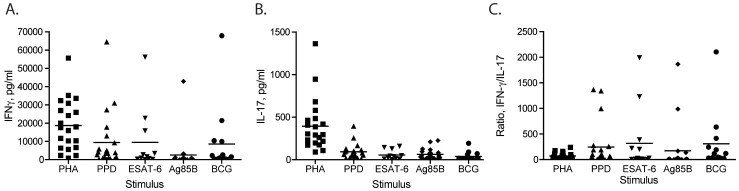
Variation of IFN-γ and IL-17 responses to mycobacterial antigens.PBMC were incubated with the indicated stimuli for 24 h (for IFN-γ responses) or 72 h (for IL-17 responses); cytokine secretion was assayed by ELISA. (A) IFN-γ secretion in response to PHA, PPD, ESAT-6, Ag85B, or live M. bovis BCG. Each symbol reflects responses of a single subject whose responses were assayed in triplicate. The horizontal bar indicates the mean value for the group. (B) IL-17 secretion in response to PHA, PPD, ESAT-6, Ag85B, or live M. bovis BCG. Each symbol reflects responses of a single subject whose responses were assayed in triplicate. The horizontal bar indicates the mean value for the group. (C) Ratio of IFN-γ to IL-17 secretion in response to the stimuli in panels A and B. Ratios were calculated using the mean value for IFN-γ and for IL-17 for each subject; the horizontal bar indicates the mean value for the group of subjects.